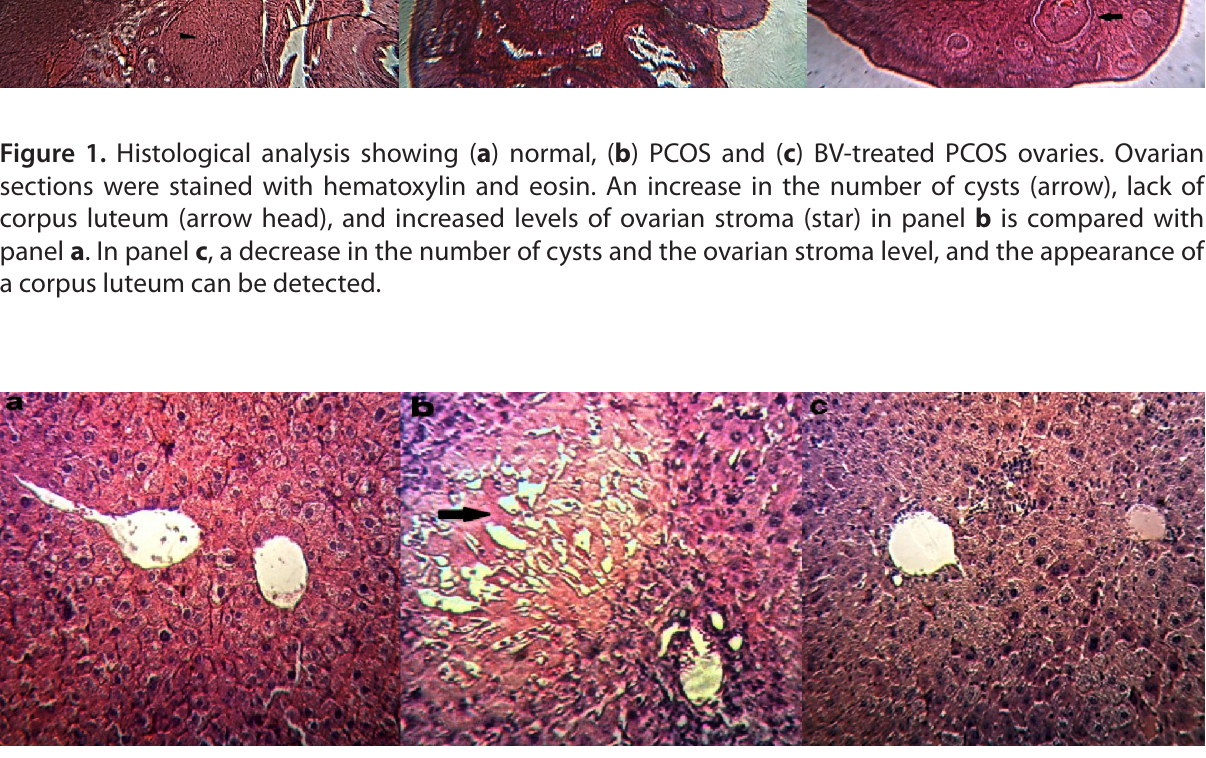
Figure 2. Liver sections from ( a ) normal, ( b ) PCOS and ( c ) BV-treated PCOS rats. Liver sections were stained with hematoxylin and eosin. Arrow points to a necrotic area in the PCOS